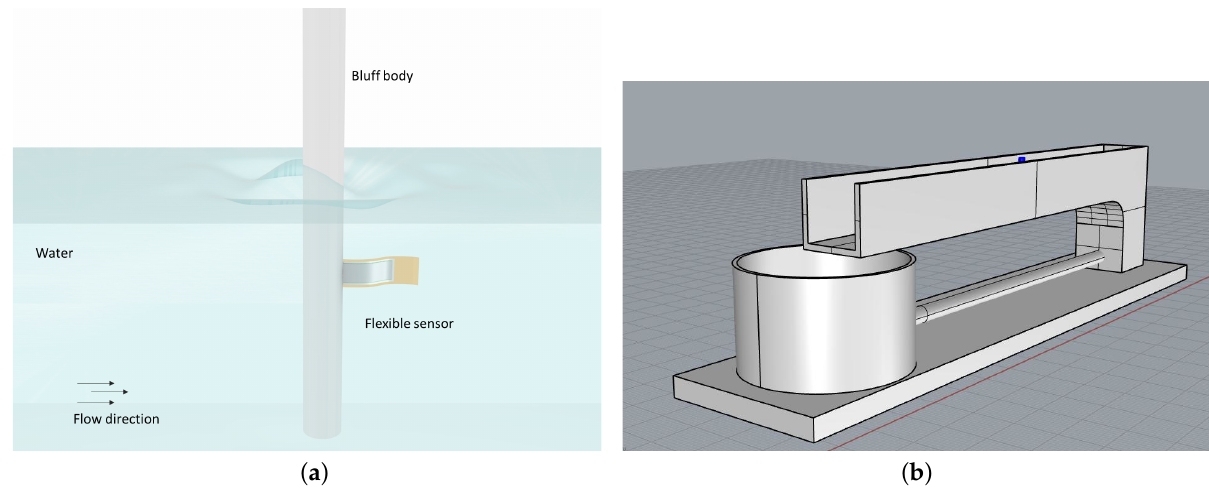
Figure 1. The sensor, mounted downstream of the bluff body, is affected by the vortexes and oscillates generating alternating voltage ( a ). 3d view of the channel flume site in EUMER Lab of Unversity of Salento ( b ).